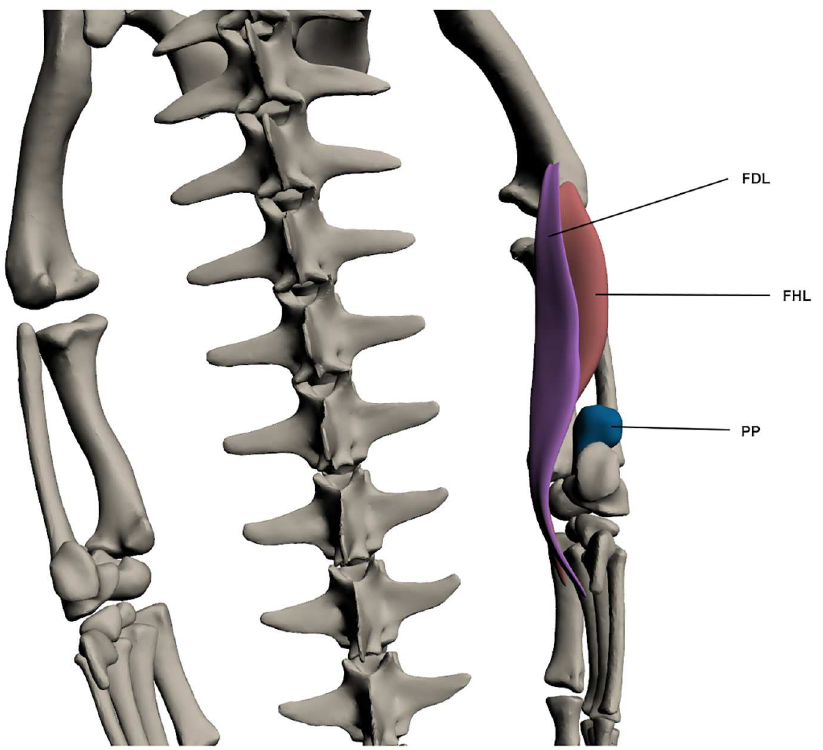
Fig 19. Deep dorsal muscles of the lower hindlimb. FDL: Flexor digitorumlongus ,FHL: Flexor hallucis longus ,PP: Pronator profundus